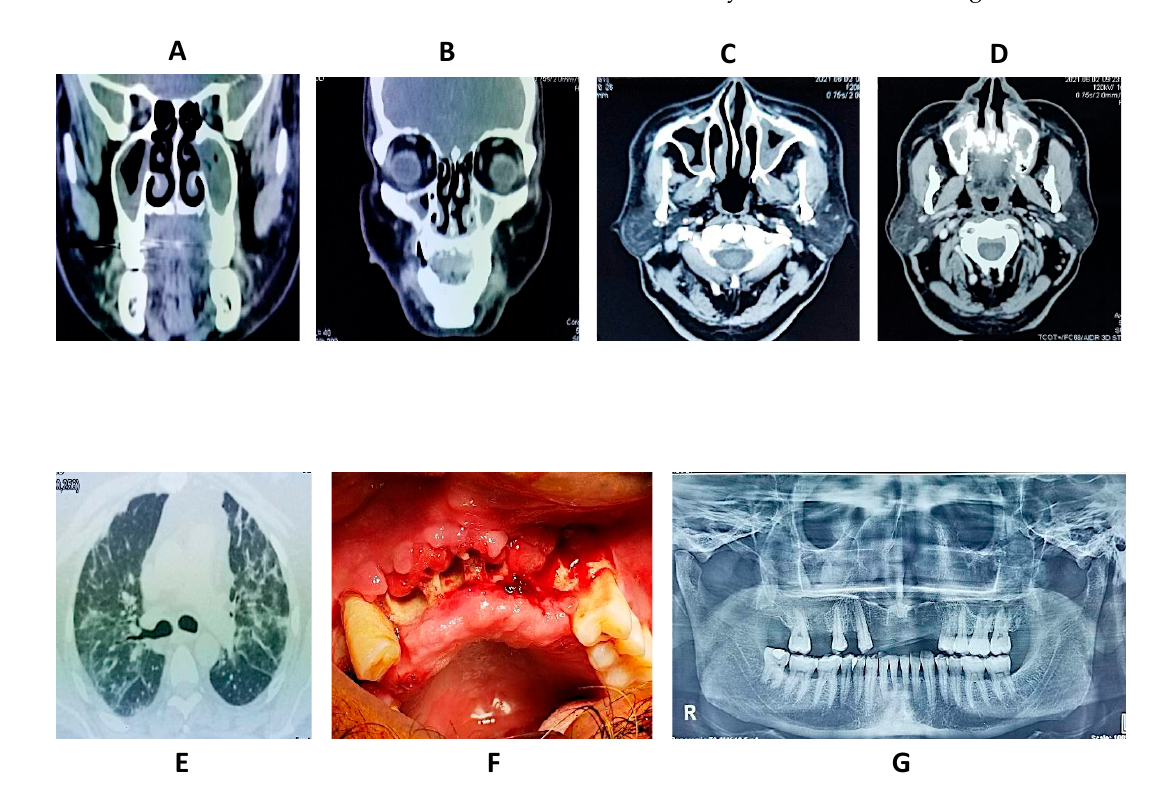
Figure 3. Coronal slices of CT scan with sinus opacification and sequestrum formation ( A ) and ( B ). Axial slices of the contrast enhanced CT scan and show involvement of maxillary sinuses and nasal turbinates ( C ) and ( D ). An axial slice of HRCT of chest showing post-COVID fibrosis ( E ). A clinical picture showing non-healing extraction sockets and necrotic bone in the maxilla, the rest of the teeth present were grade I mobile ( F ). OPG of the same patient showing sinus involvement, thickening of the lamina dura of the extraction sockets in the anterior maxilla ( G ).